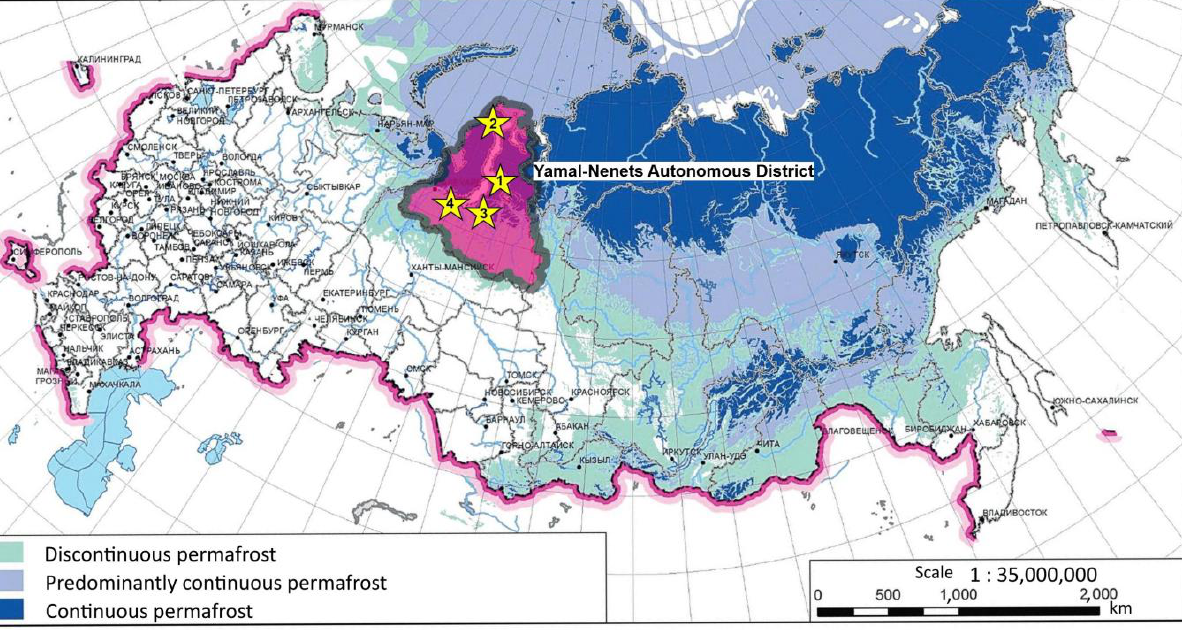
Figure 6. Areas of TEM studies (yellow stars) in the geocryological map of the USSR [30]: 1 = Urengoi area, 2 = northern Yamal Peninsula, 3 = Nadym area, 4 = southern Ob Gulf.